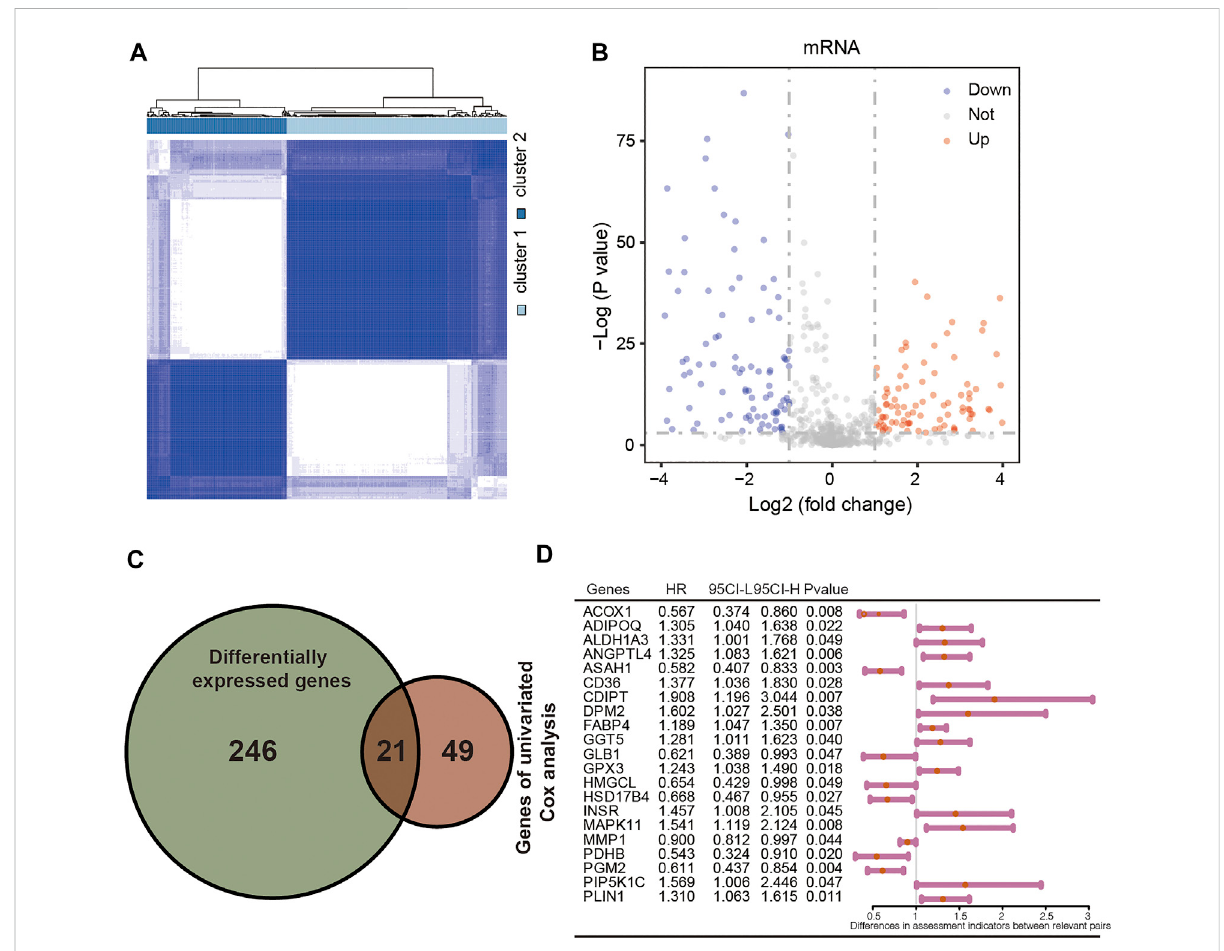
FIGURE 2 Identi fi cationofdifferentiallyexpressedLMGswithconsensusmolecularsubtypesandunivariateCoxregressionanalysis. (A) Molecularsubtype discriminationinTCGA. (B) DifferentiallyexpressedLMGsbetweensubtype1andsubtype2. (C) Venndiagramshowing21keyLMGs(theintersection of the differentially expressed LMGs and the overall survival associated LMGs using the univariate Cox regression analysis). (D) Univariated cox proportional hazards analysis of key LMGs. HR, hazard ratio; CI, con fi dence interval. LMGs: Lipid metabolism-associated